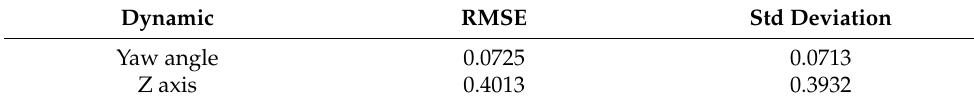
Table 5. Performance index comparison for yaw and depth identification.